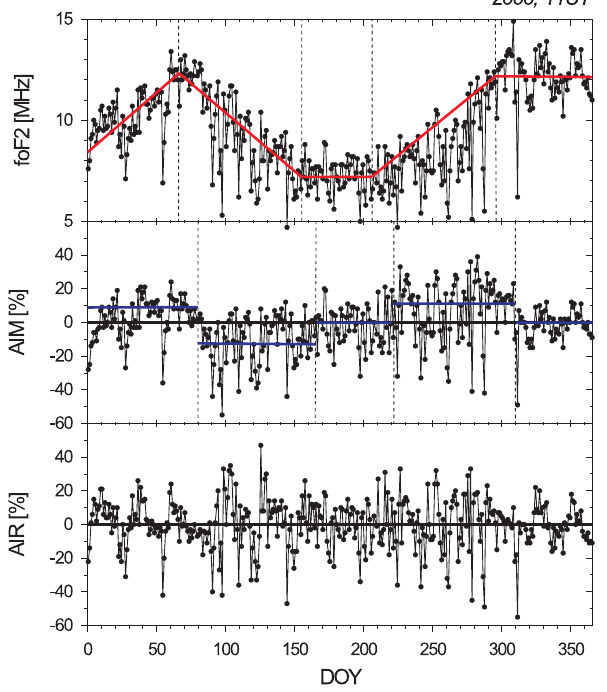
Fig. 3. Seasonal variation of fo F2 (upper part), AIM values (mid- dle part), and AIR (lower part) from ionosonde data of Juliusruh at 11:00UT during the year 2000. The red and blue lines represent the mean variations of the different parameters within different time intervals.